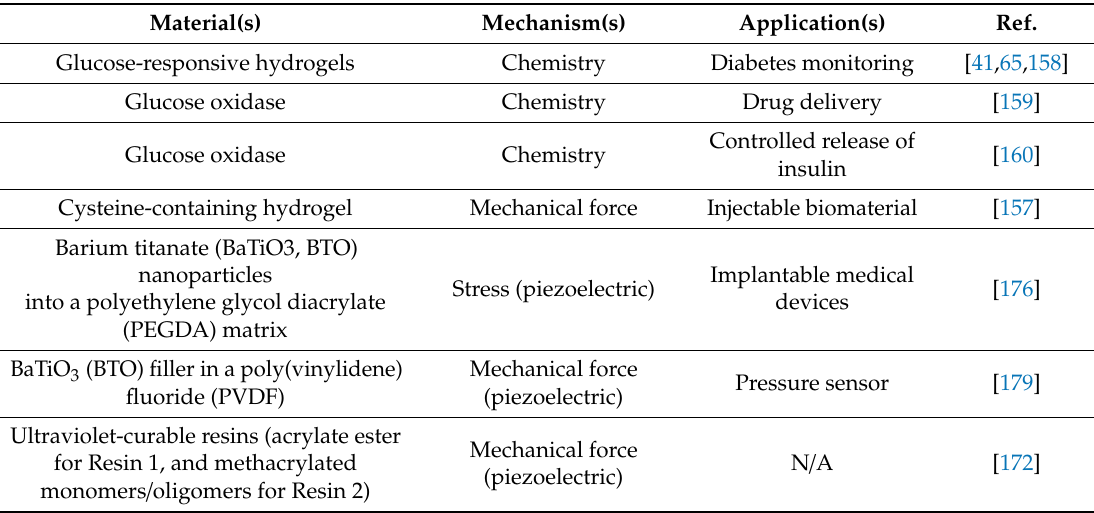
Table 7. Overview of the experiments on 4D (bio-)printing and other manufacturing approaches using chemical and mechanical-based forces as a predefined stimuli.